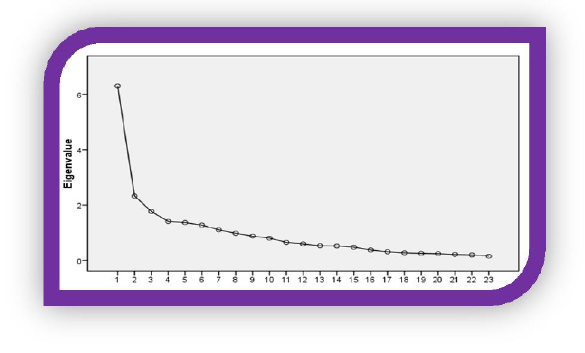
Fig. 1. The Scree